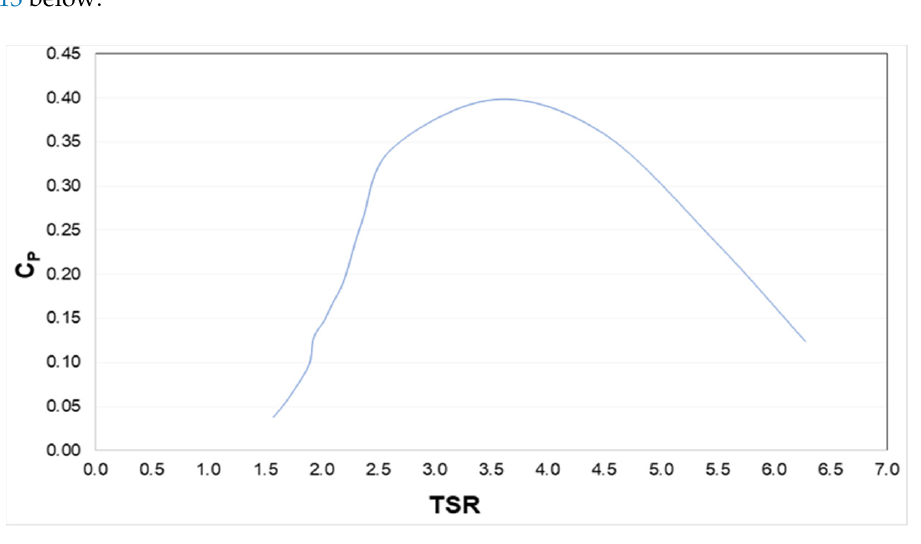
Figure 11. C P Vs. TSR for selected turbine design. Figure 12. C P Vs. TSR for selected turbine design.